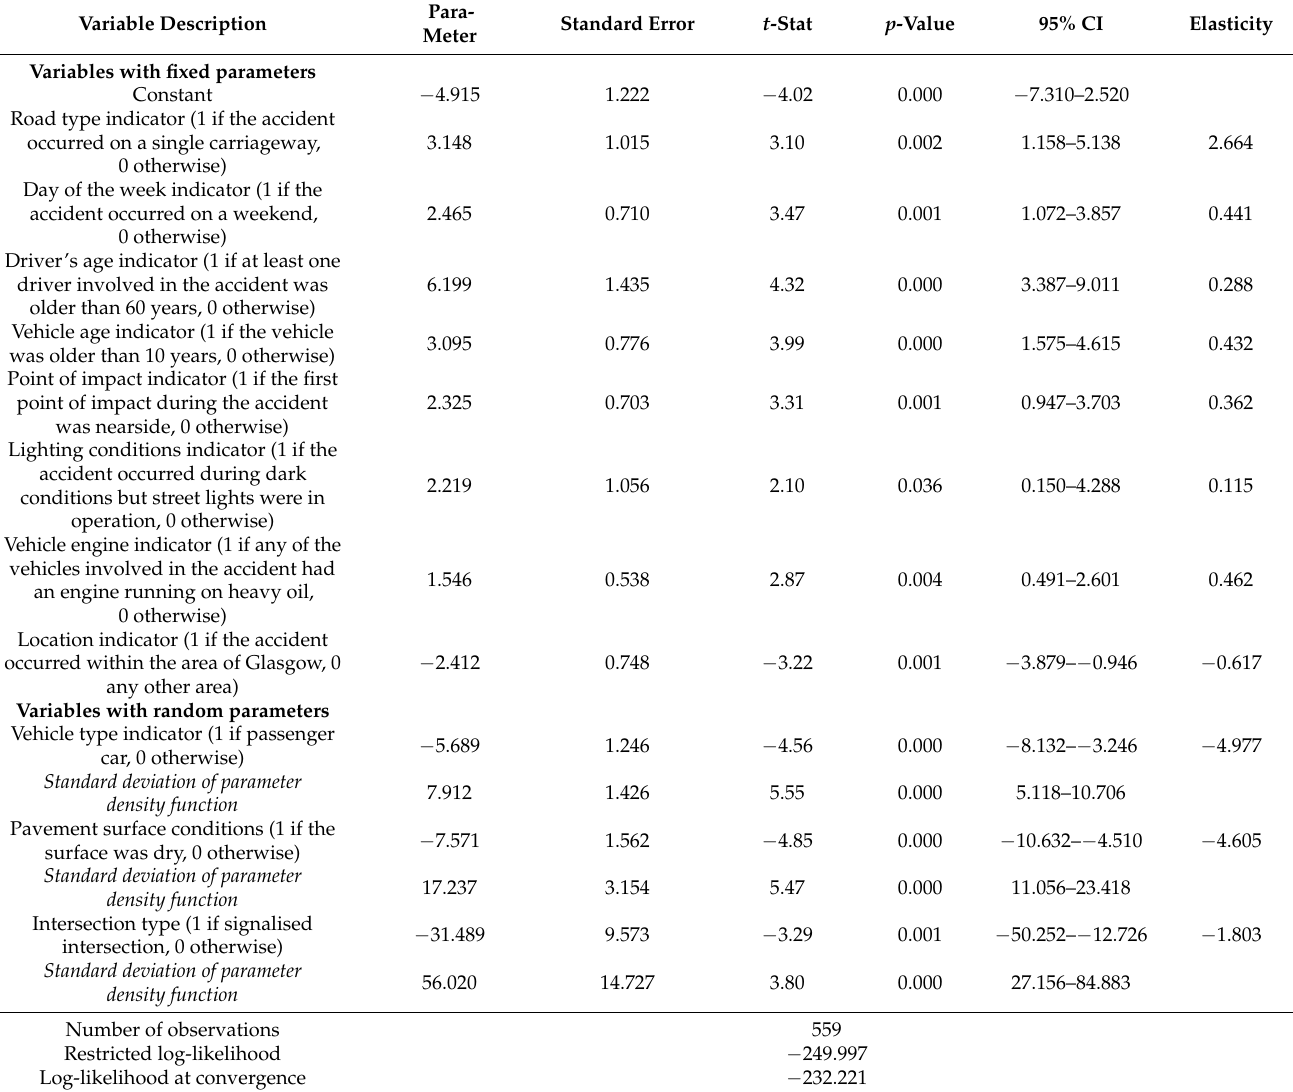
Table 2. Estimation results of the model for school travel-related accidents in urban